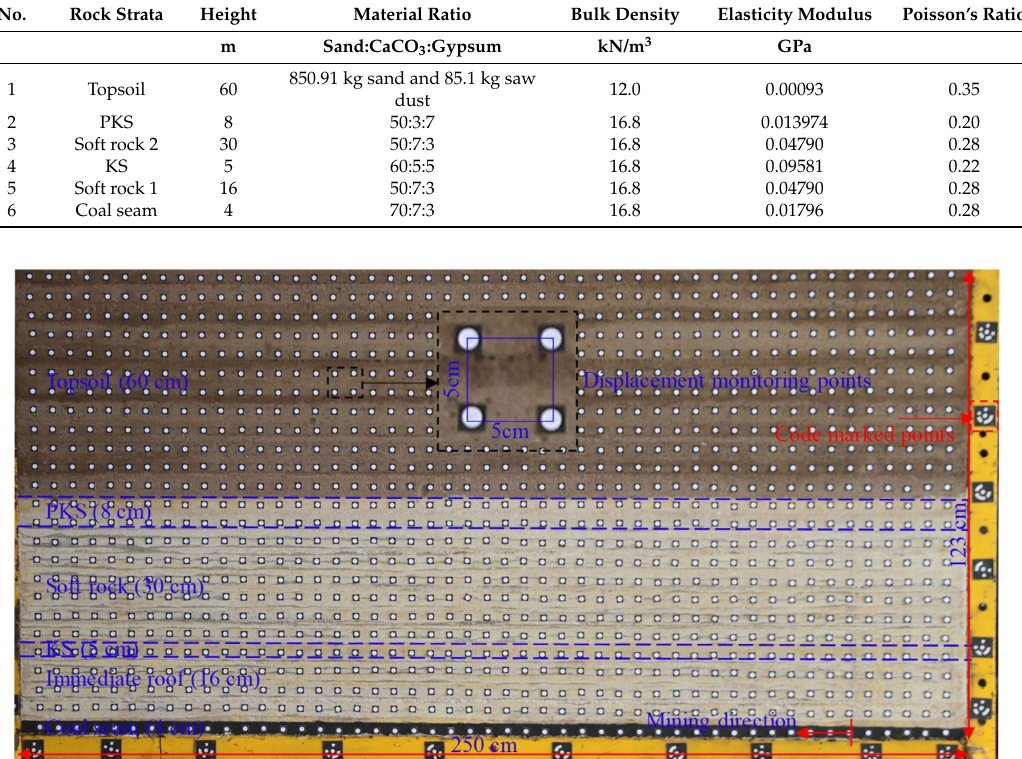
Figure 8. The actual experiment equipment and the completed